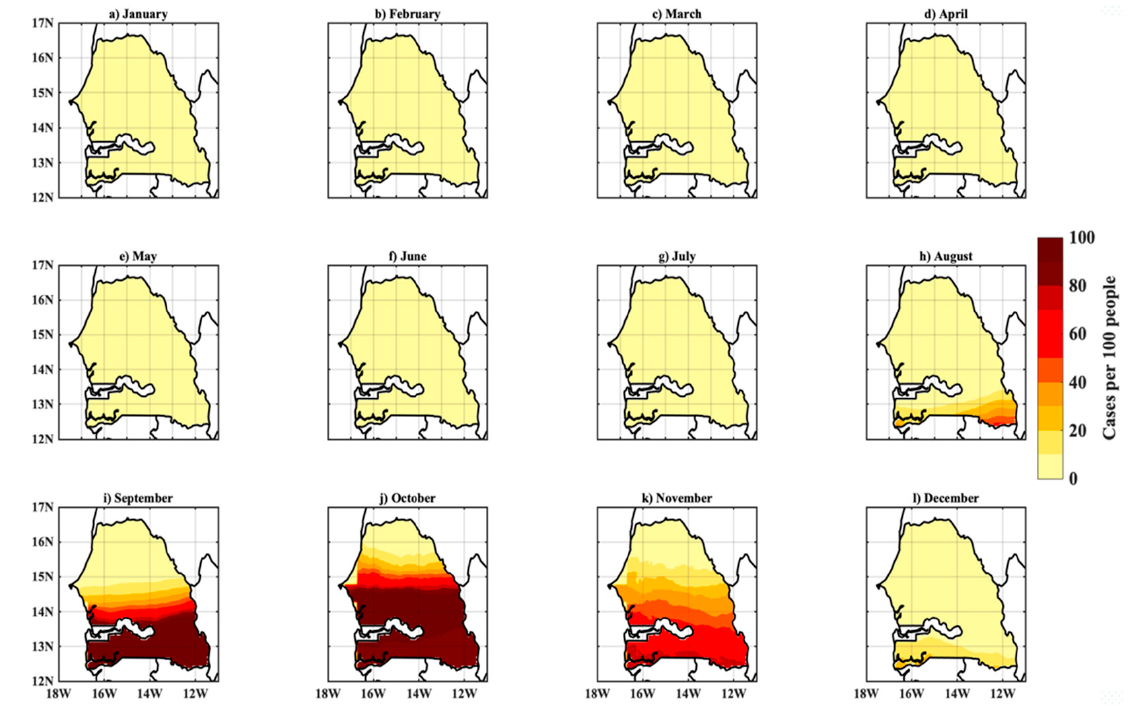
Figure 8. Spatial distribution and monthly evolution of malaria incidence for 1979–2018: LMM model simulations based on WFDEI data. ( a – l ) corresponds respectively to the evolution of malaria incidence from January to December over Senegal.